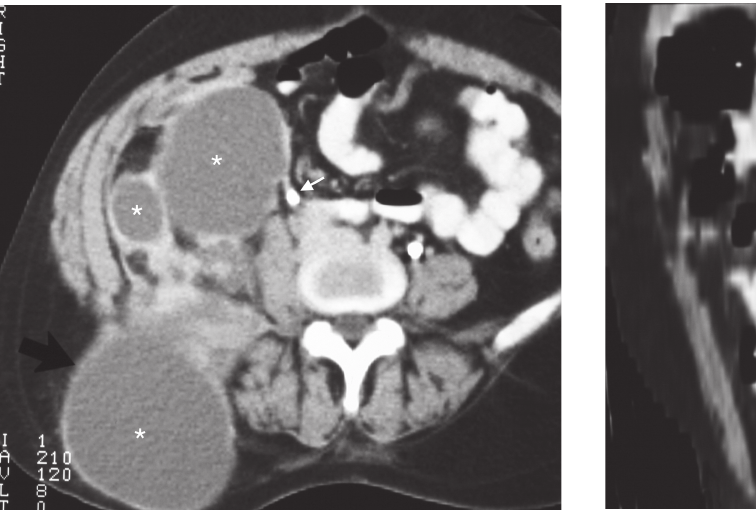
figure 2 - Sagittal reformatted post-contrast CT shows herniation of the lower most cyst herniating (black arrow) through the abdominal transversalis fascia as well as posterior strap muscles. note anteriorly displaced ureter (white